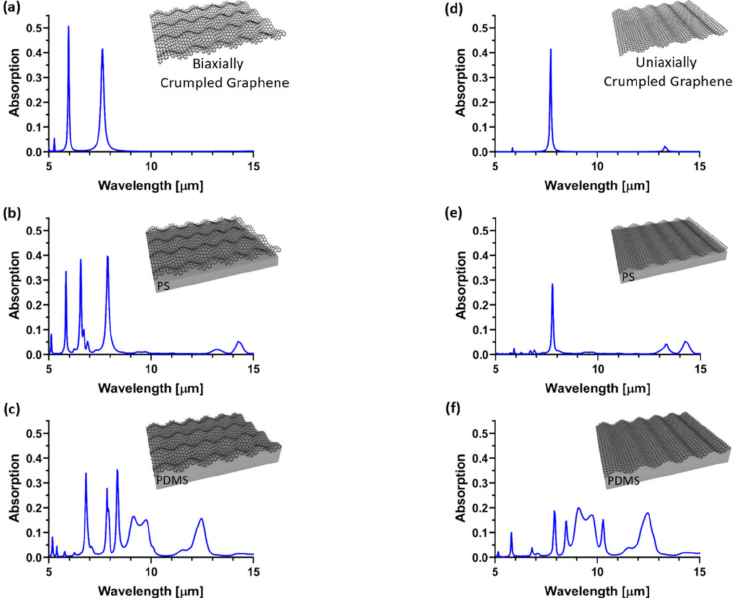
Figure 2. Optical absorption spectra of biaxially ( a ) free-standing crumpled graphene, supported on ( b ) flat PS and ( c ) corrugated PDMS substrates; and those of uniaxially ( d ) free-standing crumpled graphene, supported on ( e ) flat PS and ( f ) corrugated PDMS substrates. Here, W = 250 nm; H = 300 nm; and carrier mobility µ and Fermi energy level E f are 10,000 cm 2 /(V · s) and 0.64 eV, respectively.